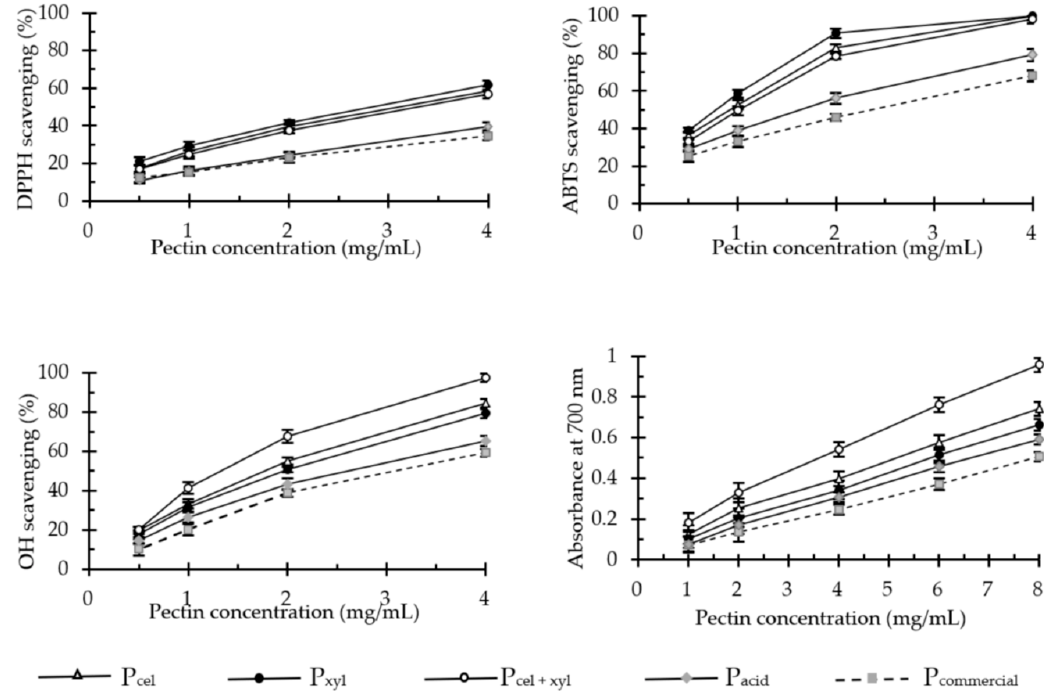
Figure 1. DPPH • , ABTS • + and • OH scavenging activity and ferric-reducing power of apple pectins (in vitro tests). Data are presented as the mean ± SD of four independent experiments. P cel —cellulase-extracted pectin; P xyl —xylanase-extracted pectin; P cel + xyl —pectin extracted with both cellulase and xylanase; P commercial —commercial apple pectin.